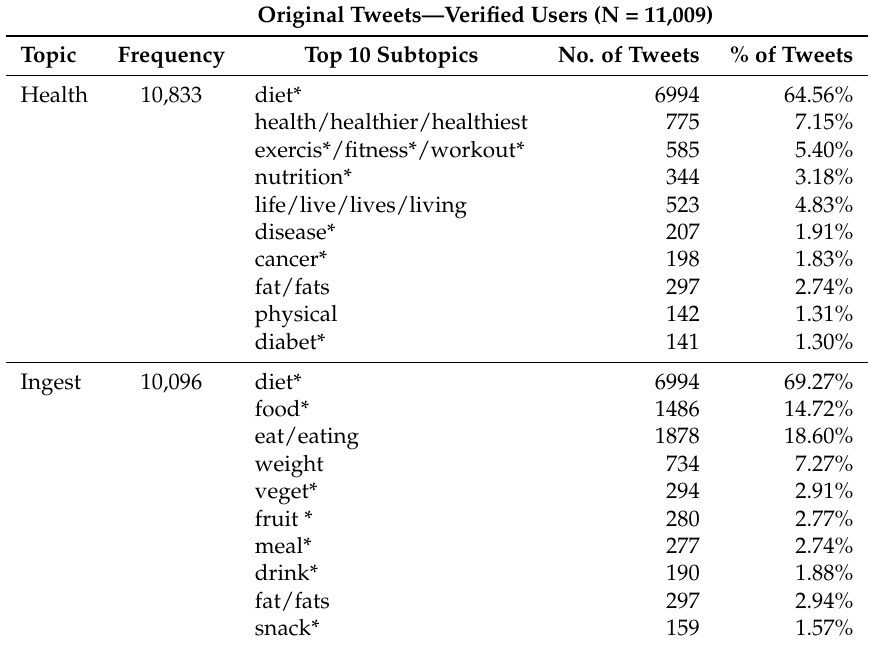
Table 9. Summary of Prominent Sub-topics in Original Tweets by Verified